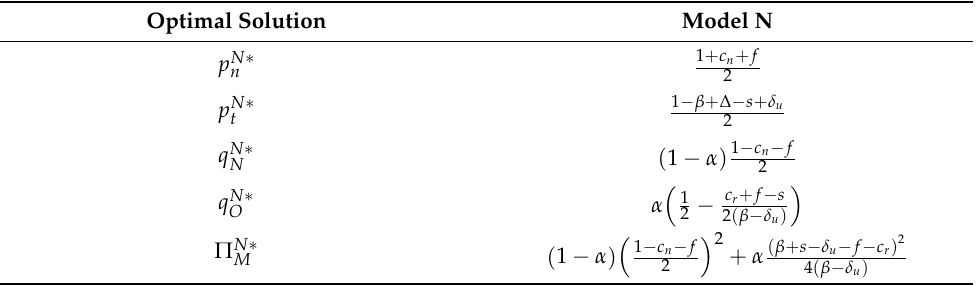
Table 3. Optimal solution of Model N.